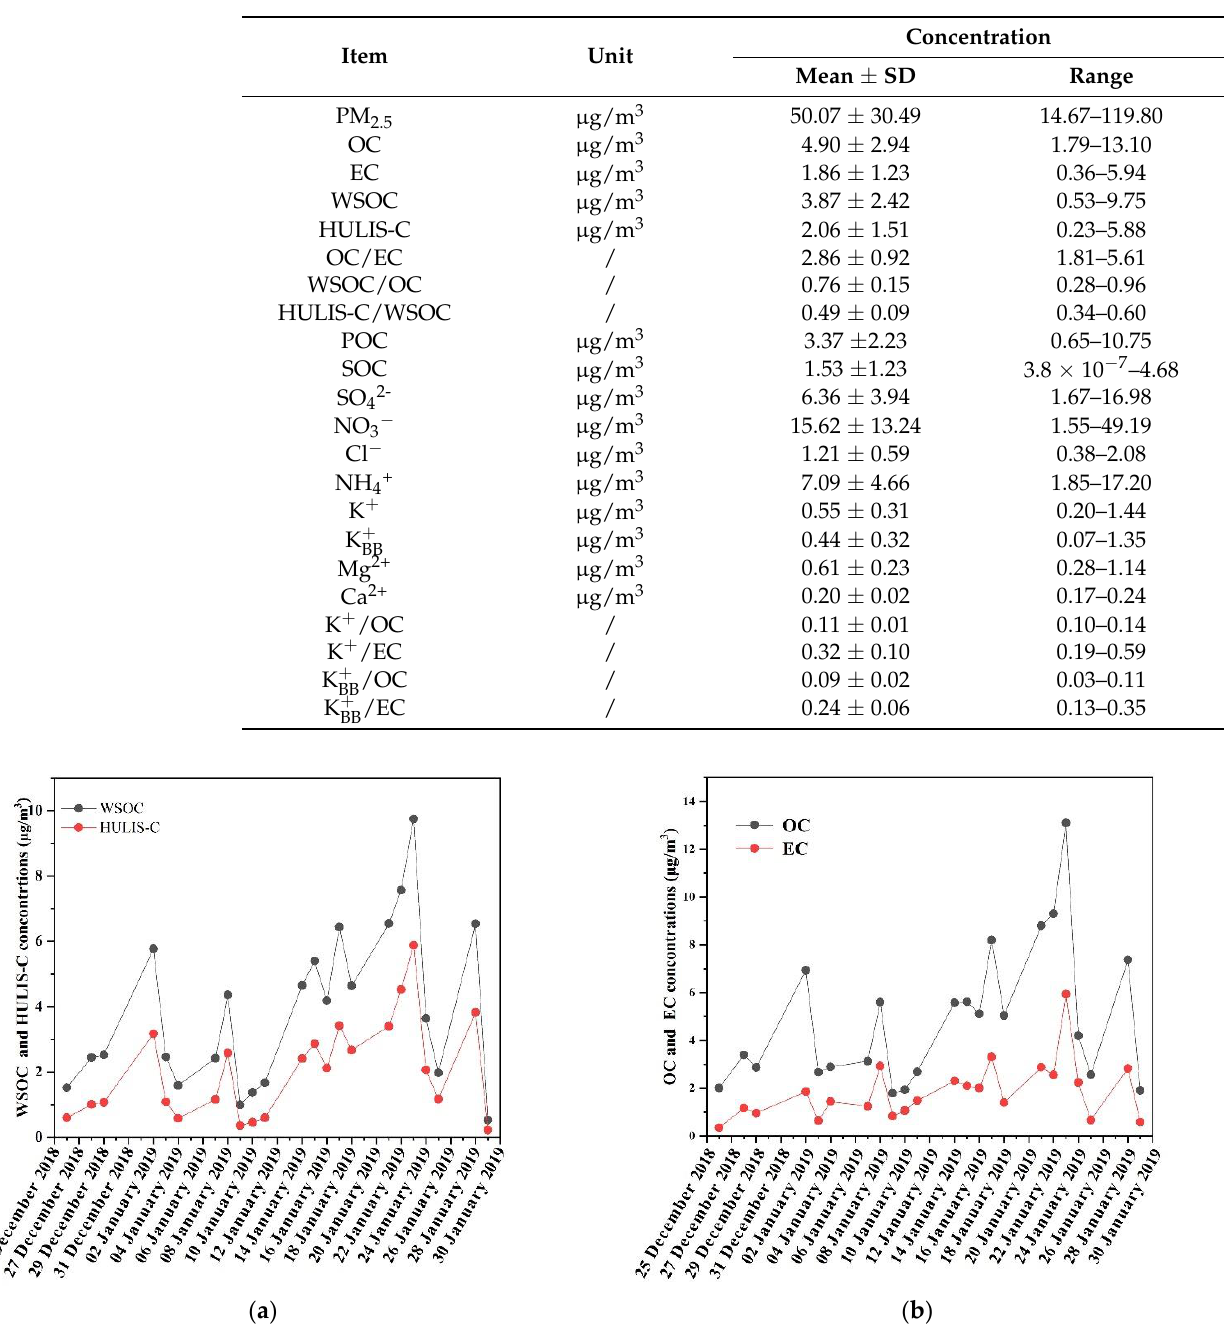
Table 1. Chemical composition of carbonaceous and ionic species of PM 2.5 in Shanghai during the monitoring period.